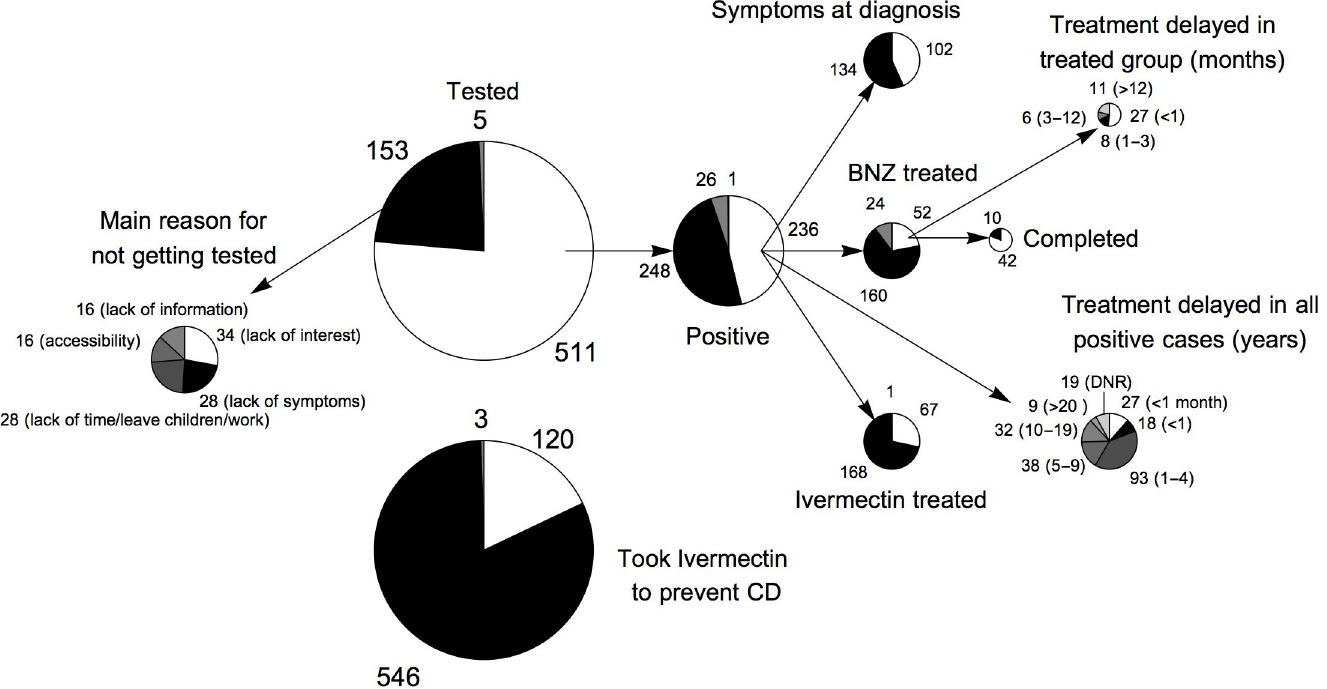
Fig 6. Secondary prevention of CD: Diagnosis and treatment. For those where no key is given, white corresponds to “yes”, black to “no”, grey corresponds to “don’t know”, and anything else is “no answer”.